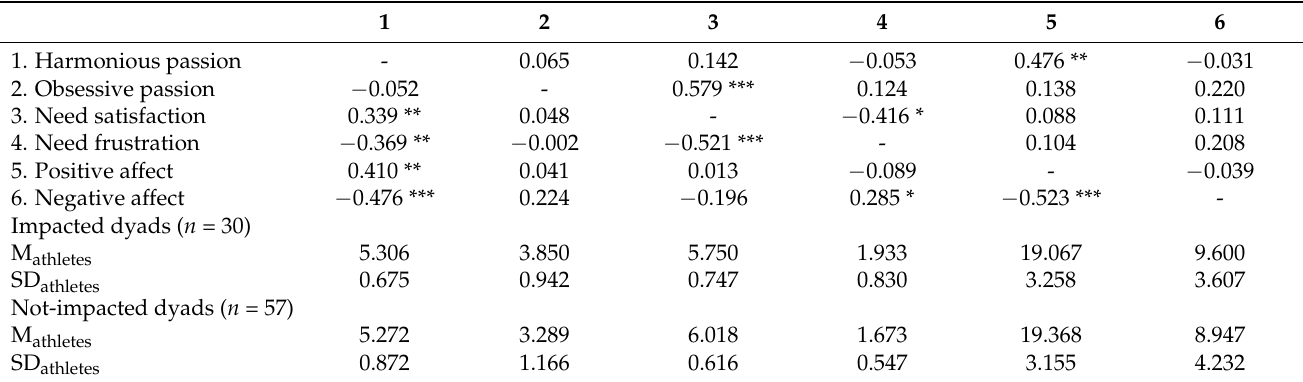
Table 2. Descriptive statistics of and correlations between the athletes’ study variables.